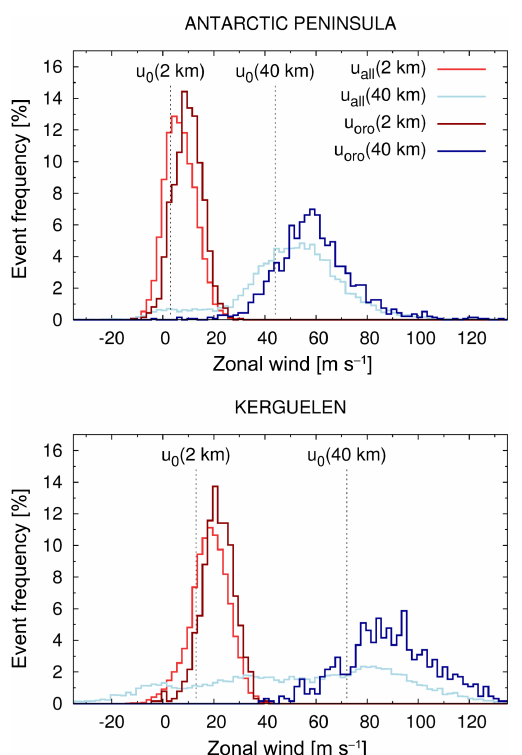
Figure 8. Histograms of ERA-Interim zonal winds at 2km (red) and 40km (blue) altitude during April–October 2003–2014 at the Antarctic Peninsula and Kerguelen. Light colored curves show data for all satellite overpasses. Dark colored curves show data only for overpasses with orographic wave events. Dotted lines indicate the zonal wind thresholds of the mountain wave prediction